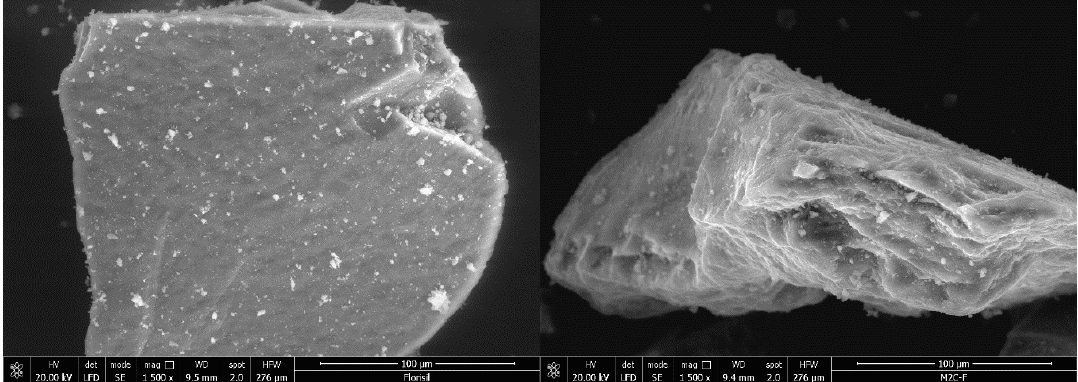
Figure 3. SEM image of adsorbent before and after impregnation.